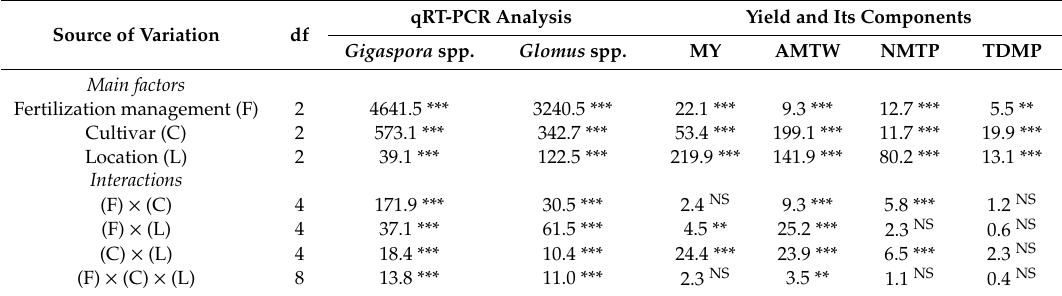
Table 3. F -values as absolute value of main factors and their interactions resulting from ANOVA of qRT-PCR analysis, yield and its